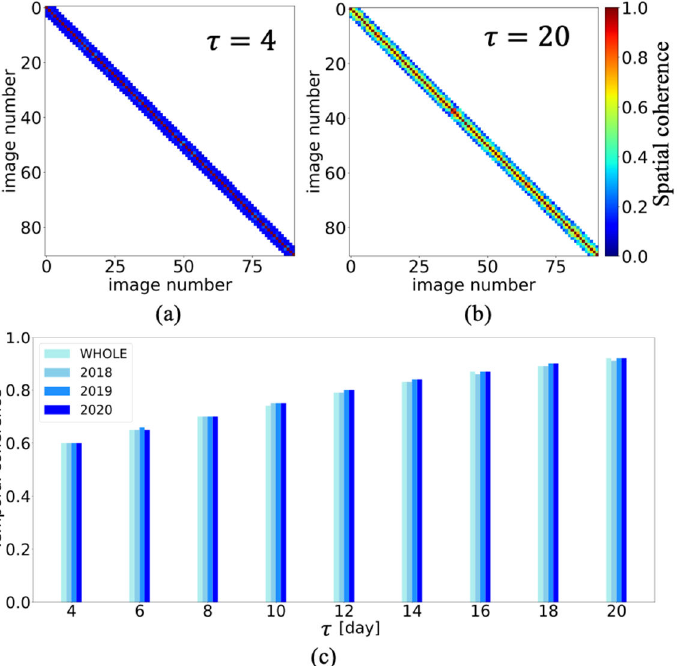
Figure 8. Simulation results of varying τ from 4 to 20 days with γ ∞ = 0.1 for SUBSET and WHOLE. ( a ) Spatial coherence matrix with τ = 4. ( b ) Spatial coherence matrix with τ = 20. ( c ) Temporal coherence bar plot for SUBSET and WHOLE.